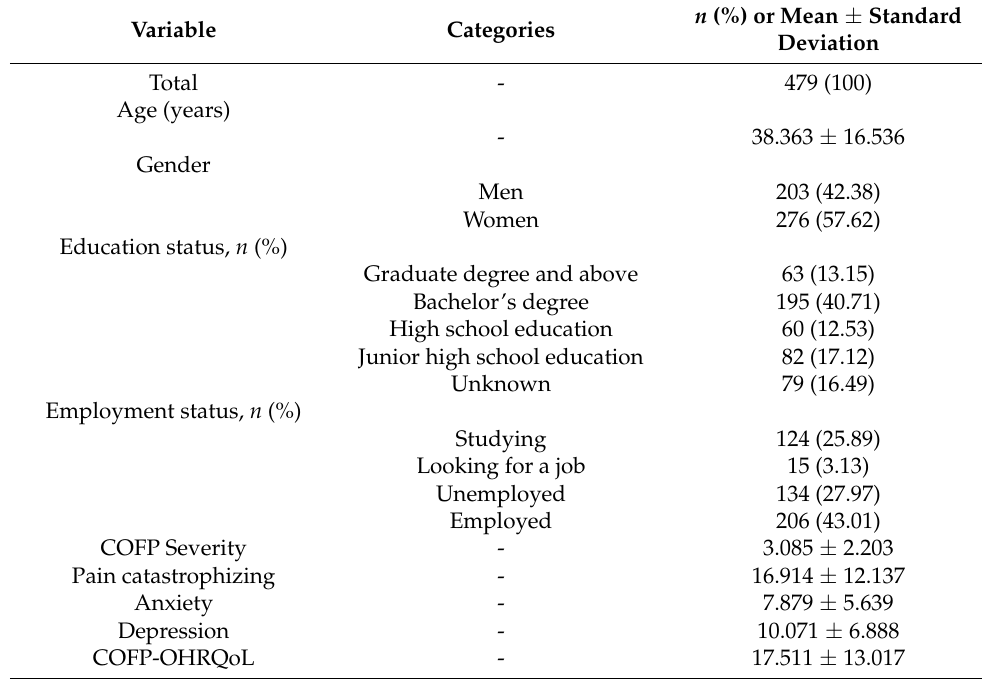
Table 1. Sociodemographic characteristics of Chinese COFP